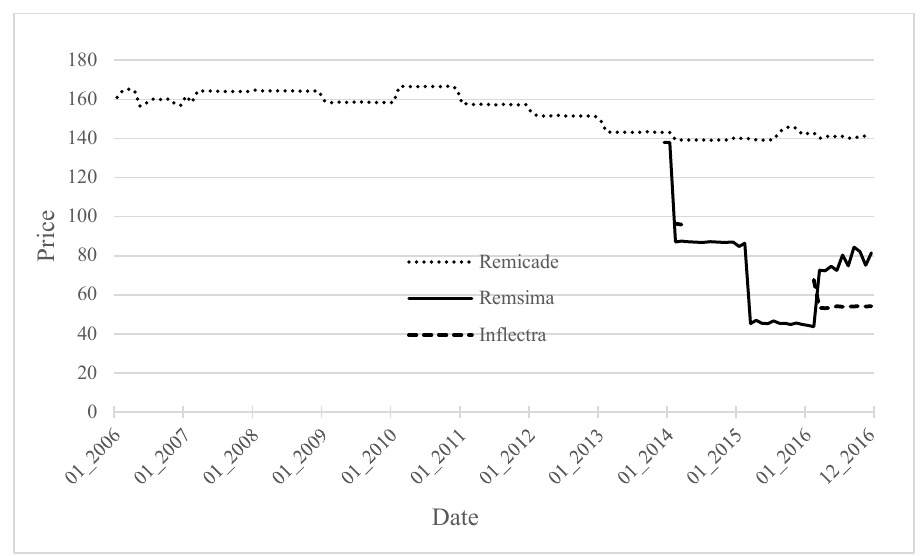
Figure 1: Calculated monthly prices for Remicade (original brand) and the two